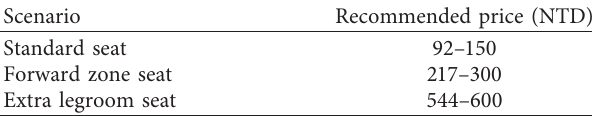
Table 12: Recommended prices for various services. Scenario Recommended price